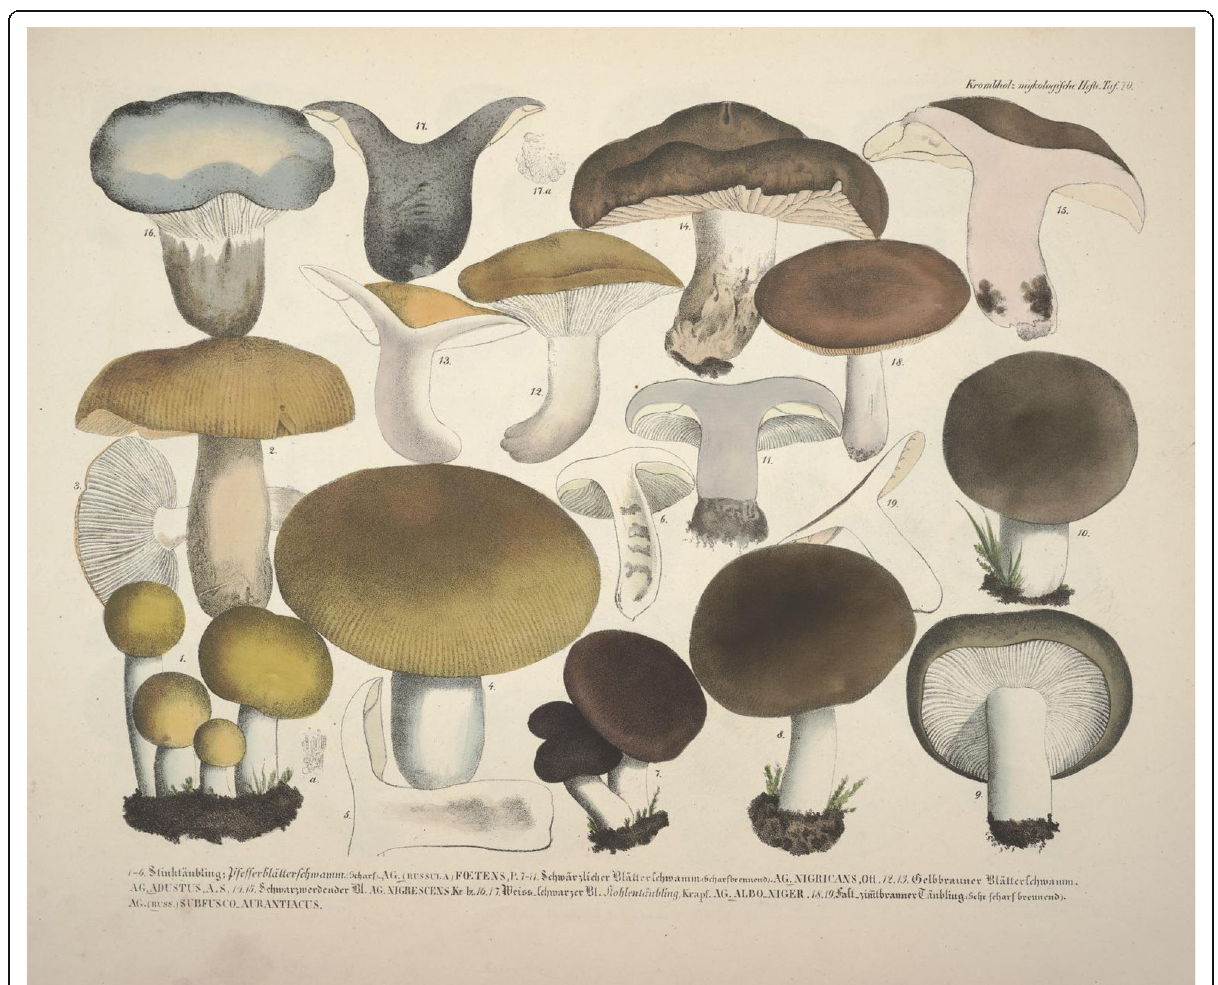
Fig. 7 Krombholz (1845). Image from the BHL (Biodiversity Heritage Library). Contributed by Missouri Botanical Garden, Peter H. Raven